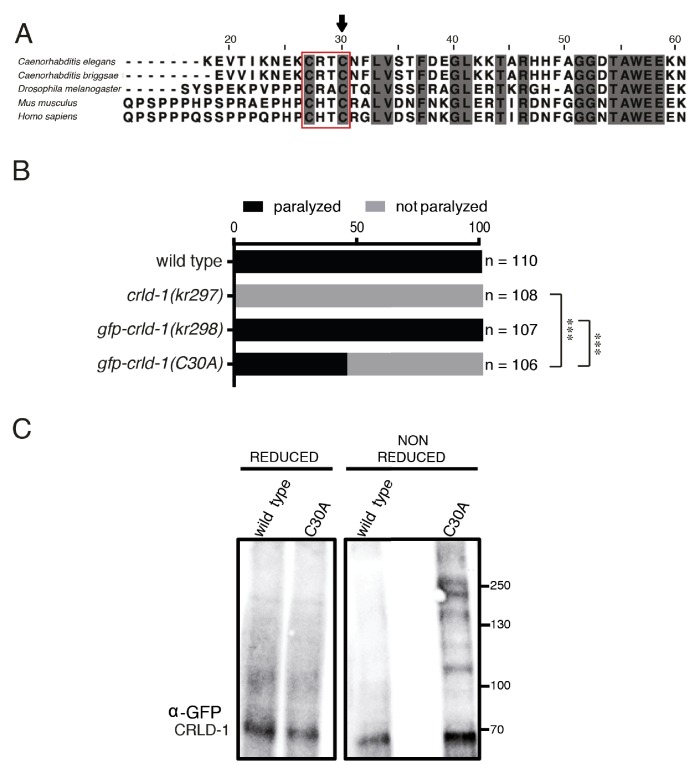
CRLD-1 displays putative PDI-like activity.(A) ClustalO alignment of C. elegans CRLD-1 with orthologous CRLD proteins from nematodes, fly, and vertebrates. The conserved CXXC motif present in the WE domain is boxed. Identical residues conserved in all species are highlighted in dark gray. The position of the cysteine residue that was mutated to generate the C30A mutation in gfp-crld-1(C30A) knock-in worms is indicated by an arrow. (B) Animals expressing the C30A mutation in the crld-1 gene display partial levamisole resistance. Gray bars indicate the percentage of moving animals after overnight exposure to 1 mM levamisole, and black bars indicate the percentage of paralyzed animals. Experiments were repeated three times, n = number of animals tested. ***p<0.001, after Bonferroni correction, Fisher exact probability test. (C) The substrate-trapping CRLD-1 C30A mutant formed high molecular weight mixed disulphide complexes that were resolved under reducing conditions. In contrast, wild-type CRLD-1 did not form higher molecular weight complexes with putative substrate proteins. Total protein extract from gfp-crld-1(kr298) wild-type and gfp-crld-1(kr302) C30A mutant worms were separated by SDS-PAGE followed by Western blot analysis for GFP to detect CRLD-1.